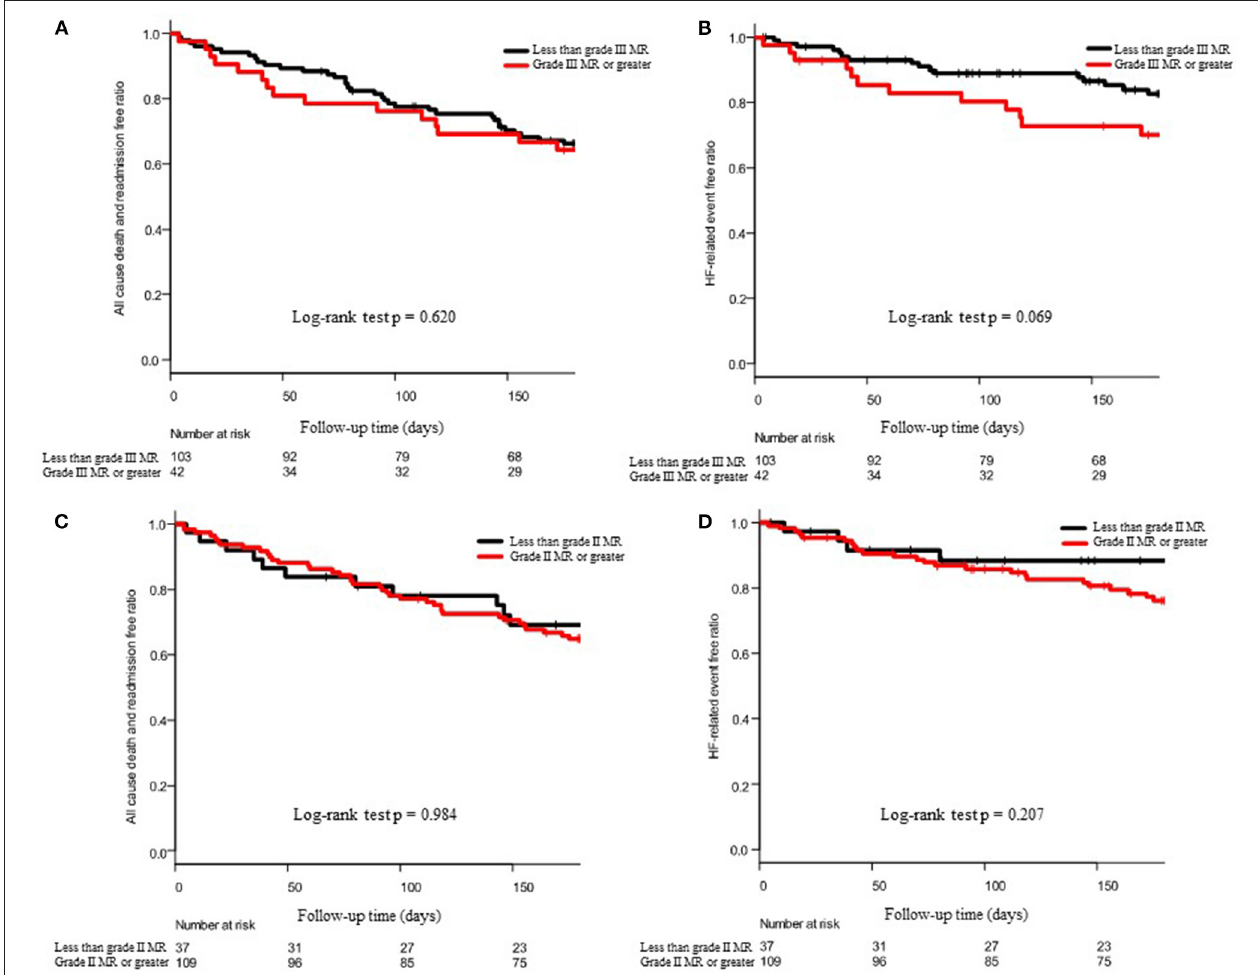
FIGURE 3 | Effect of the severity of MR on 6-month outcomes. (A,C) show the Kaplan–Meier curve of all-cause death and admission and (B,D) show the Kaplan–Meier curve of HF-related death and admission. In (A,B) , patient groups were divided into the grade III MR or greater and less than grade III, and in (C,D) , patients were divided into the grade II MR or greater and less than grade II. The p -values of the log-rank test were described at the bottom of each